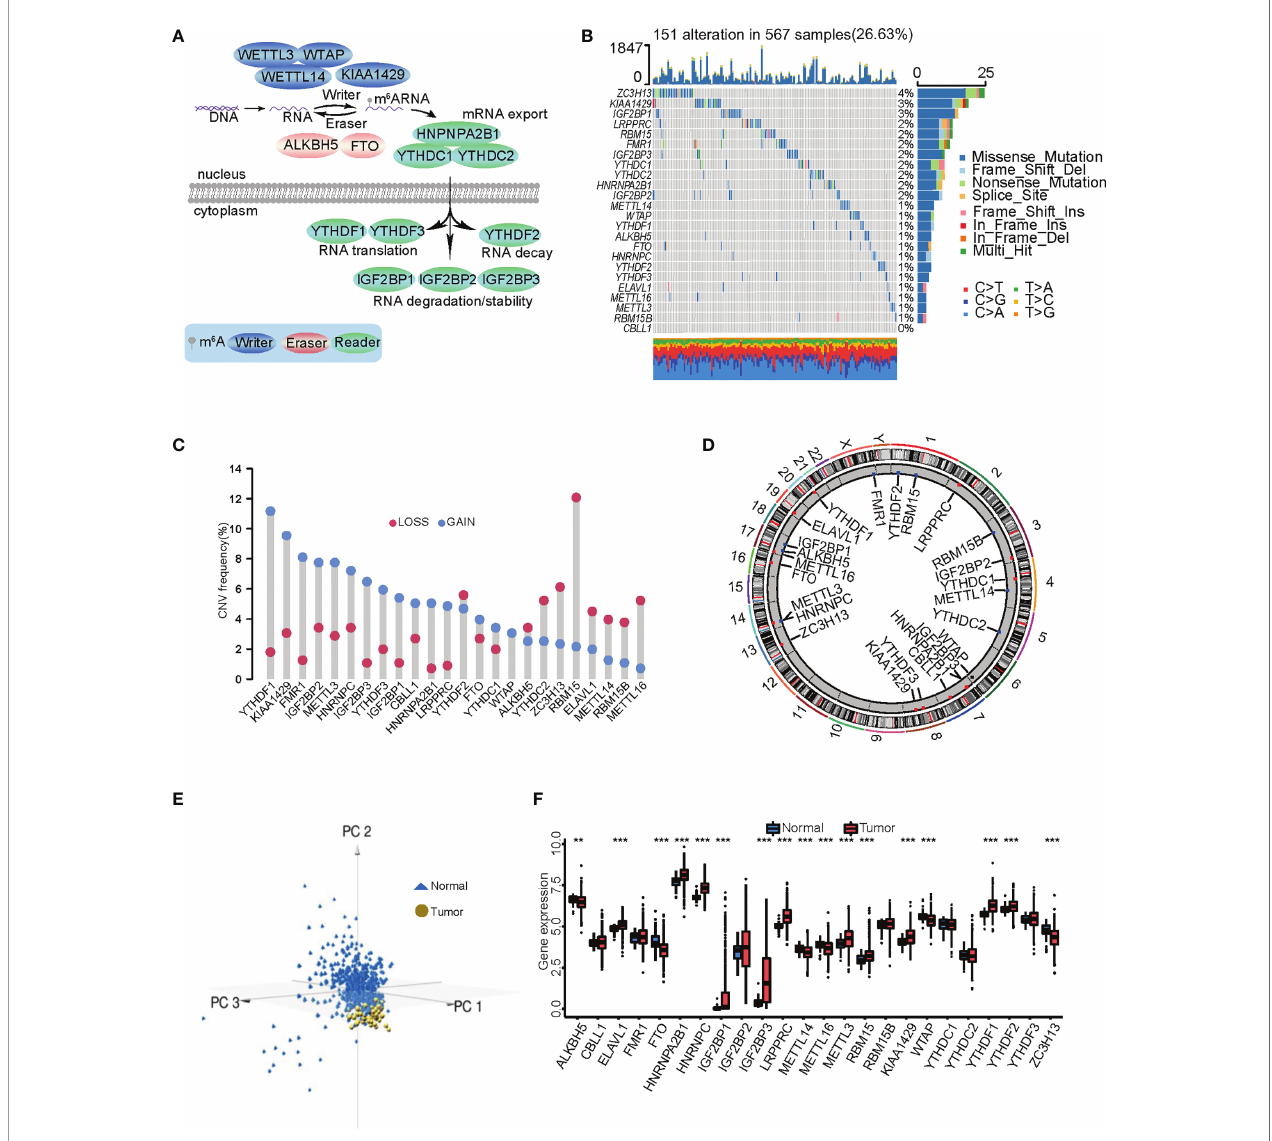
FIGURE 1 | Gene mutation pro fi le and expression of m 6 A regulators in lung adenocarcinoma (LUAD). (A) The dynamic and reversible modi fi cation process of m 6 A RNA methylation mediated by 24 m 6 A regulators and their major biological functions. (B) The mutation frequency of 24 m 6 A regulators in 567 patients with LUAD. Each column represents each individual patient. The upper bar plot represents TMB. The number on the right represents the mutation frequency in each regulator. The bar graph on the right shows the proportion of each variant type. The stacked bar chart below shows the conversion of each sample. (C) Histogram re fl ecting the CNV of the m 6 A regulators. The height of the bar indicates the frequency of variation. Gain, blue; loss, red. (D) The speci fi c location of the CNVs in m 6 A regulators on 23 chromosomes. (E) Principal component analysis of 24 m 6 A regulators adapted to distinguishing tumors from normal samples. Tumor was marked with blue and normal with golden. (F) Differences in the expression of the 24 m 6 A regulators between normal and LUAD tissues. The asterisks show the statistical p - value (** p < 0.01; *** p <